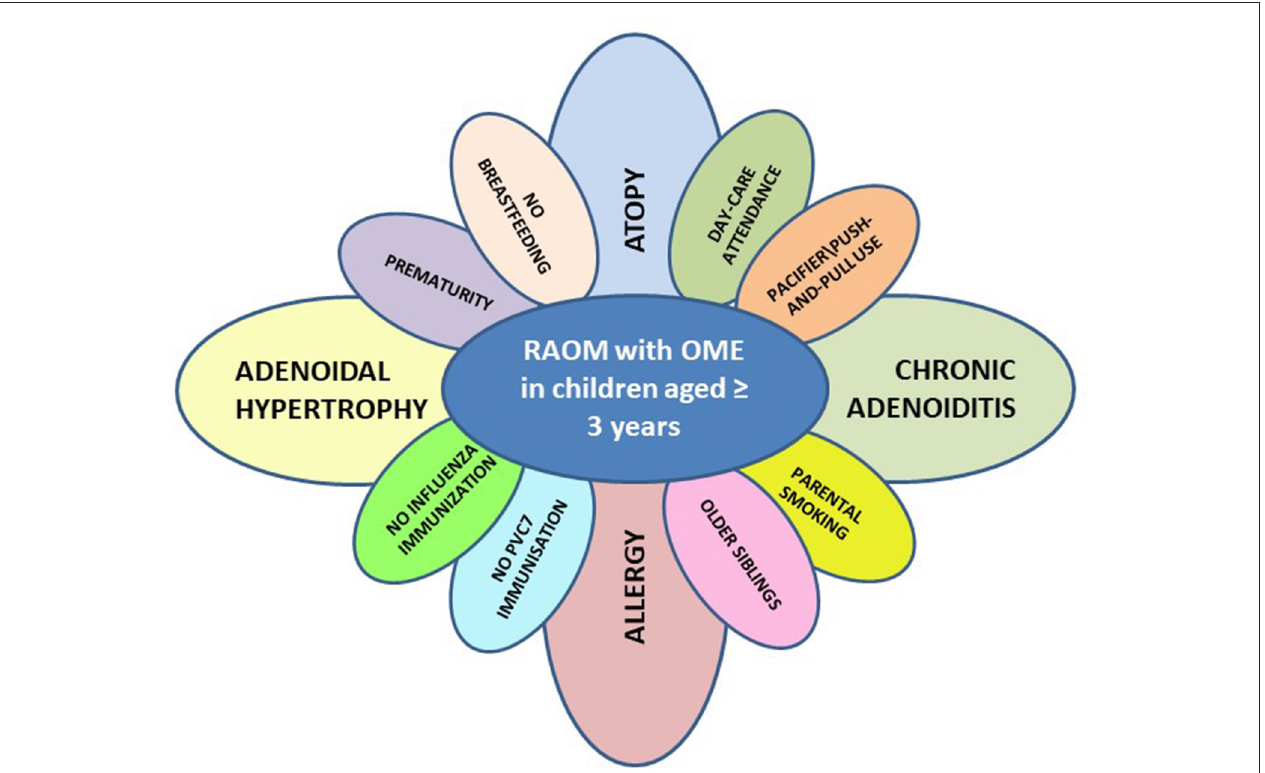
FIGURE 1 | Risk factors for phenotypic pattern of disease characterized by the presence or recurrent acute otitis media with persisting otitis media with effusions among acute episodes (RAOM with OME) in children aged ≥ 3 years (PVC7, pneumococcal conjugate